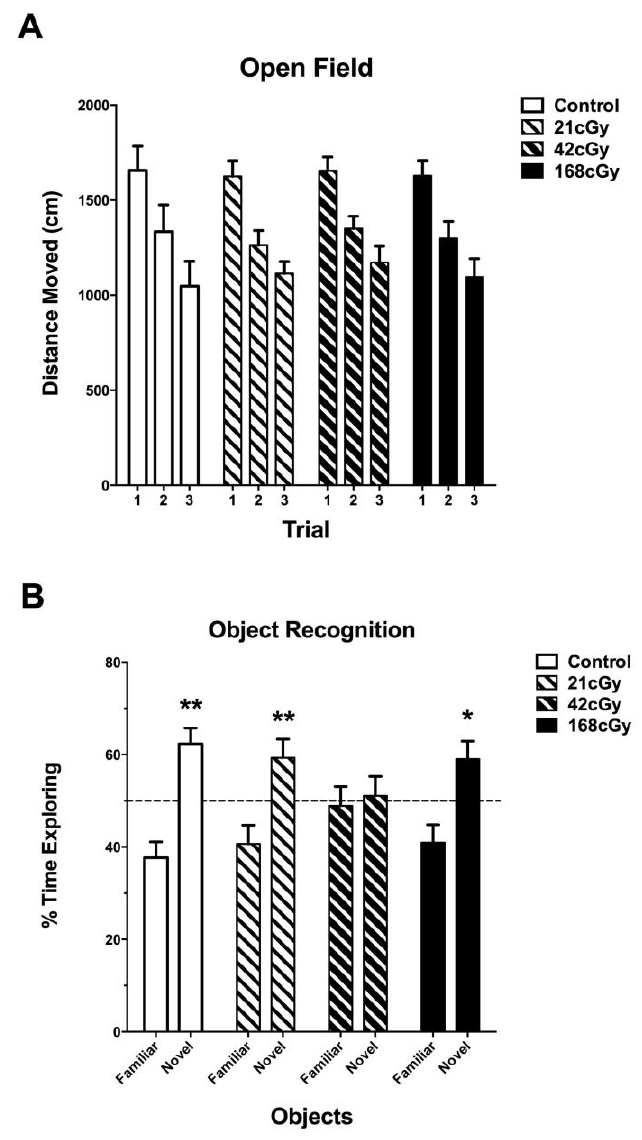
Figure 2. Behavioral performance in the open field and object recognition. ( A ) Habituation to the open field. All mice habituated to the open field (effect of trial, p < 0.001), but there was no effect of irradiation. ( B ) Object recognition. Sham-irradiated mice and mice irradiated with 21 cGy or 168 cGy showed object recognition and spent more time exploring the novel object than the familiar object, but mice irradiated with 42 cGy showed impaired object recognition. Control: n = 13 mice; 21 cGy: n = 23 mice; 42 cGy: n = 20 mice; 168 cGy: n = 16 mice. * p < 0.05 versus familiar object; ** p < 0.01 versus familiar object.